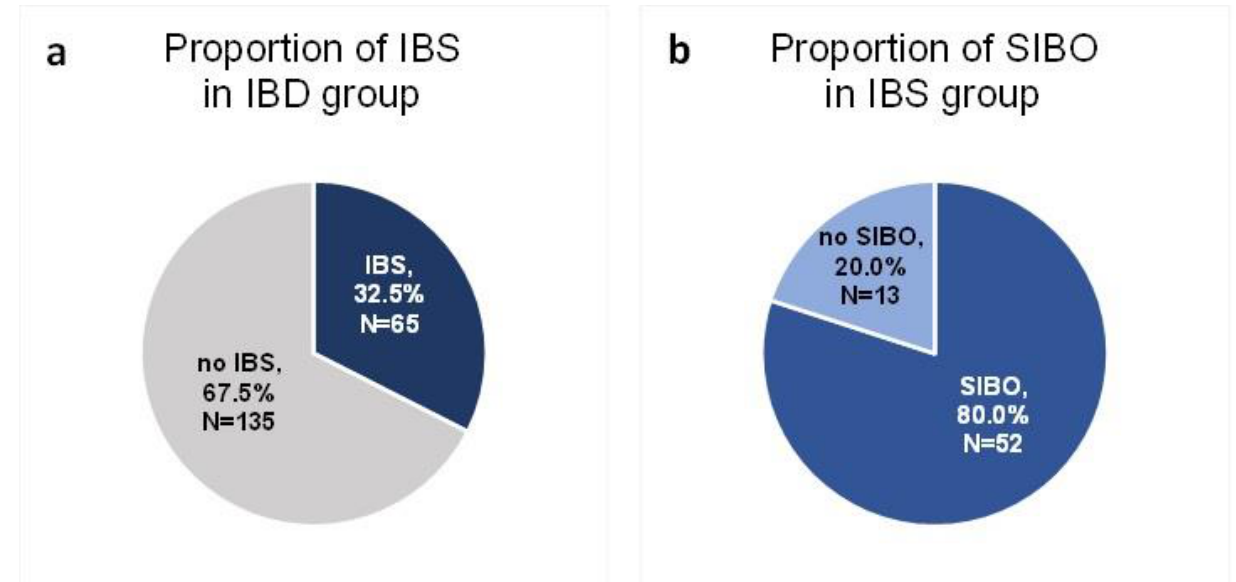
Figure 2. Proportion of IBS ( a ) and SIBO ( b ) in the study group.